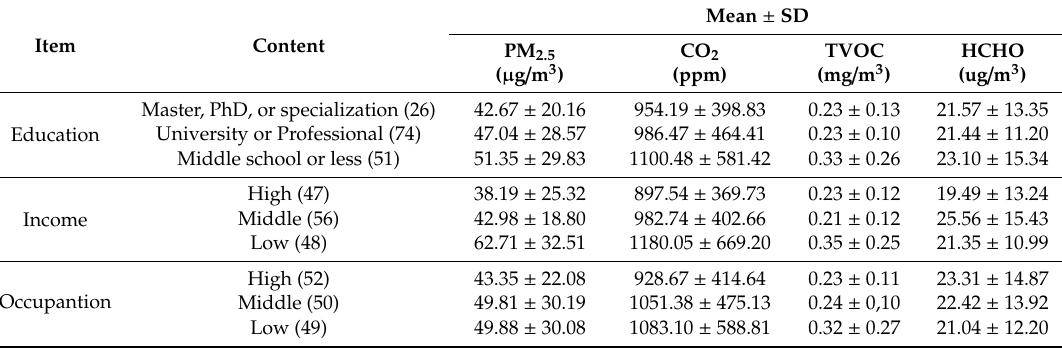
Table 5. The PM 2.5 , CO 2 , TVOC, and HCHO concentration in the di ff erent education, income and occupation